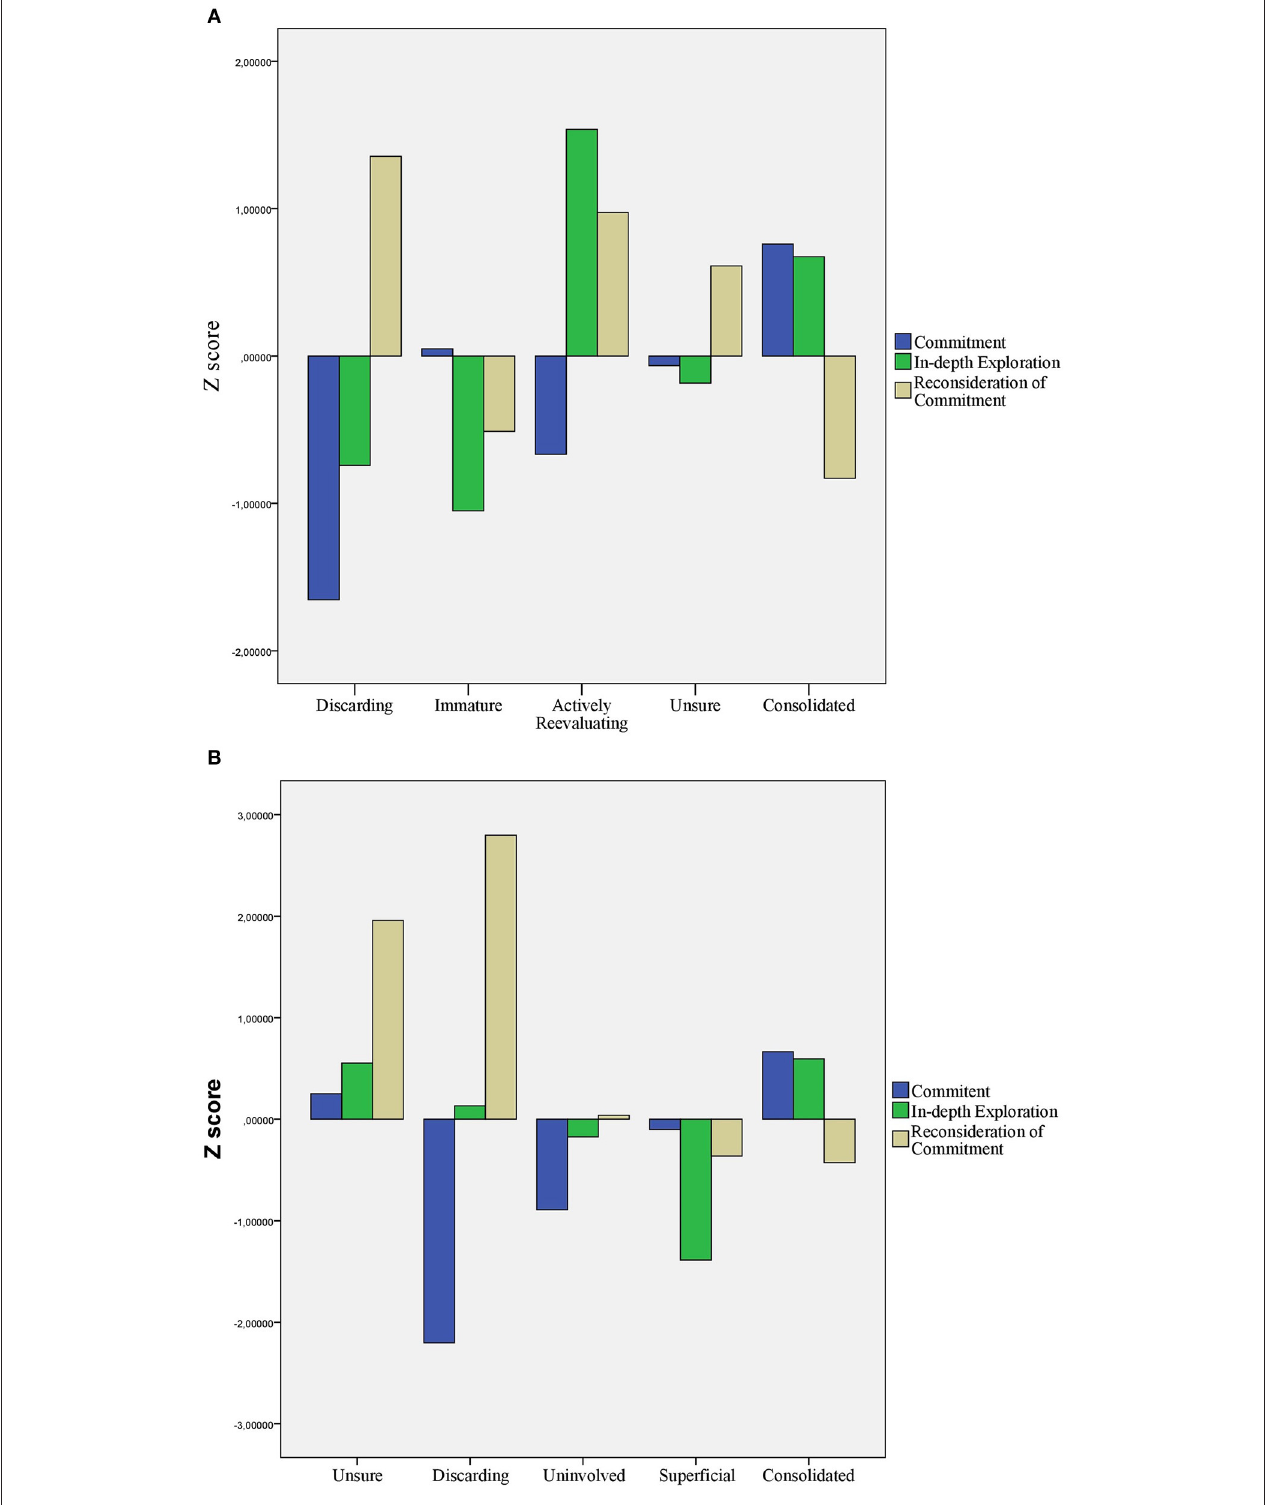
FIGURE 2 | Clusters based on the Z- scores of the dimensions of H-UMICS; results of k-means clustering. Clusters in charts (A,B) are based on H-UMICS (educational identity) and H-UMICS (relational identity), respectively.